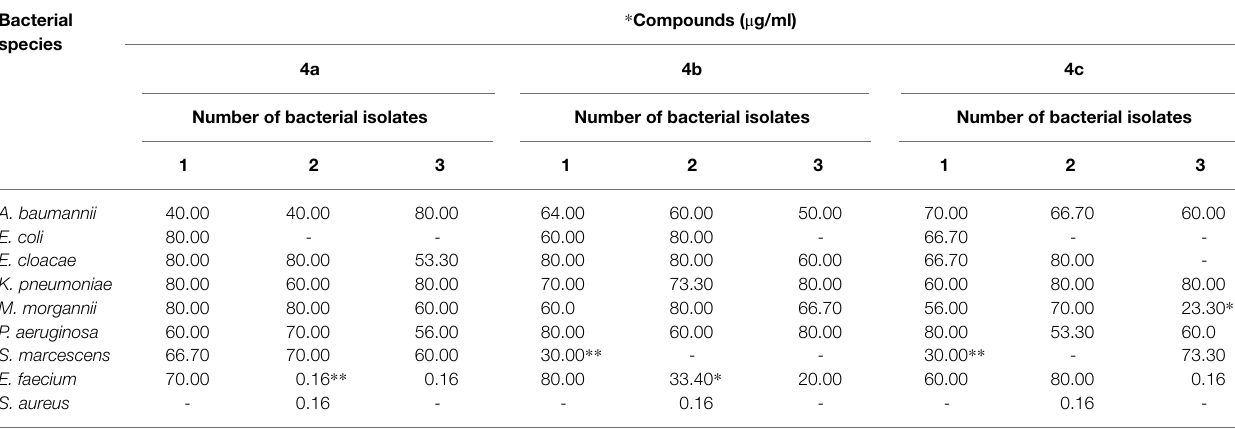
TABLE 2 | Mean of the minimum inhibitory concentration (MIC) of DHPM against multiresistant bacteria of hospital origin. Bacterial species